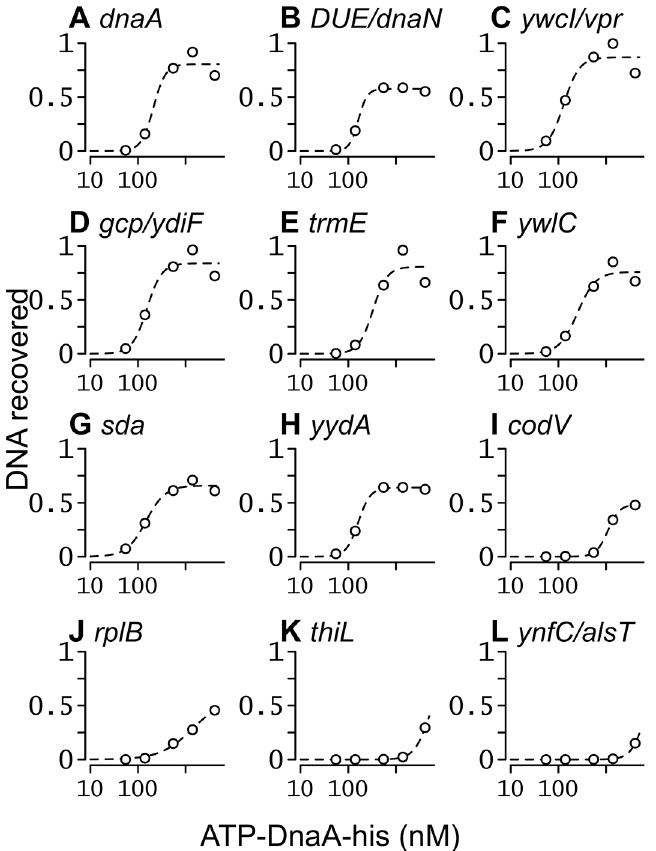
Fig 5. Binding curves for ATP-DnaA-his for selected chromosomal regions. The relative amount of DNA recovered from different chromosomal regions is plotted on the y-axis, versus the ATP-DnaA-his concentration on the x-axis. The curves were obtained from fitting the data to the Hill Equation. Chromosomal locations (nucleotide position in the sequence of AG1839, peak number in S1 Table, and nearby genes) include: (A) 150, #1, upstream of rpmH and dnaA ; (B) 1841, #2, downstream of dnaA and upstream of the DUE and dnaN ; (C) 3885674, #5, upstream of ywcI and vpr ; (D) 627955, #3, downstream of gcp and ydiF ; (E) 4191071, #4, upstream of trmE and downstream of jag ; (F) 3772105, #6, upstream of ywlC and downstream of ywlB ; (G) 2620059, #7, upstream of yqeG and sda ; (H) 4113012, #8, upstream of yydA and downstream of yyzF ; (I) 1670814, #9, inside codV ; (J) 137727, #10, inside rplB ; (K) 624773, #40, inside thiL ; (L) 1922157, #127, upstream of ynfC and alsT